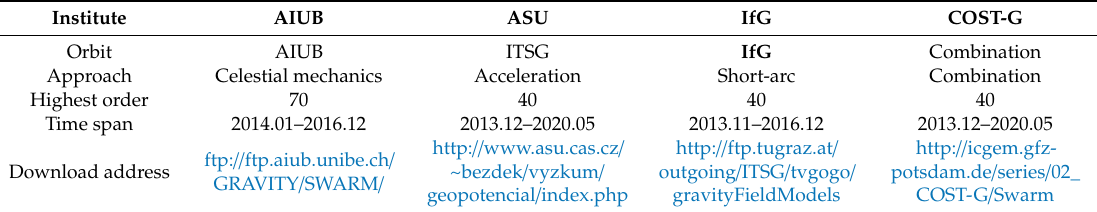
Table 1. Comparisons of Swarm time-variable gravity (TVG) data solutions from di ff erent institutes.